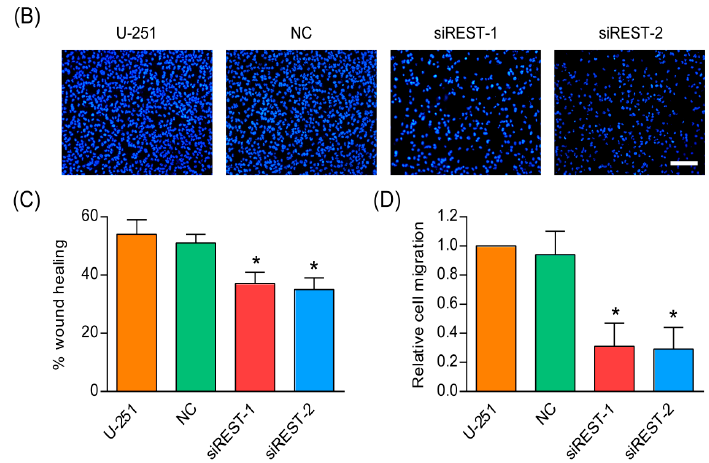
Figure 7. REST silencing reduced migration of U-251 cells. ( A ) In vitro scratch assay carried out with U-251 cells over 24 h; ( B ) Transwell migration assay was conducted with U-251 cells over 12 h; ( C ) The quantification of wound healing assay; ( D ) The quantification of transwell assay. * p < 0.05 compared with NC group. Scale bars in A and B indicate 200 nm.